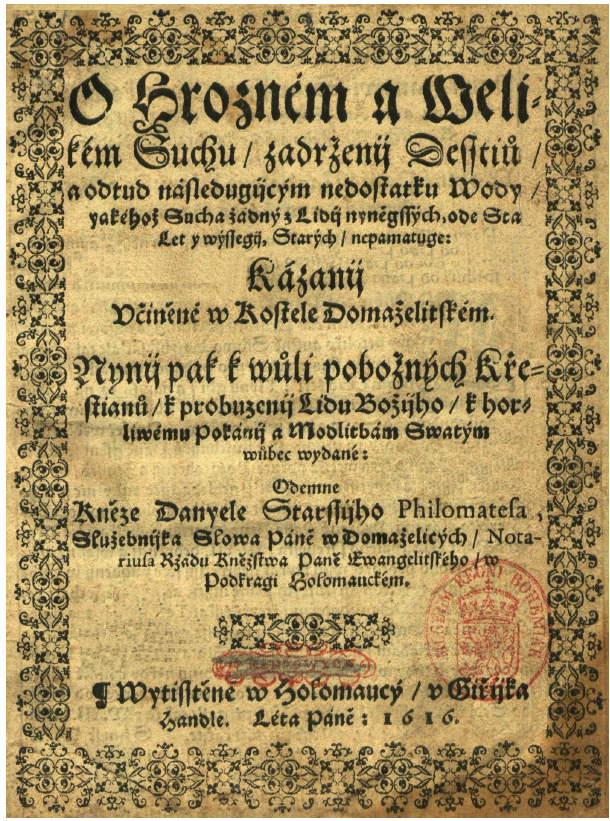
Figure 5. Printed sermon by the Reverend Daniel Philomates the Elder (AS5) related to the severe drought of 1616 in the Czech Lands (from the collection of the National Museum, Prague).